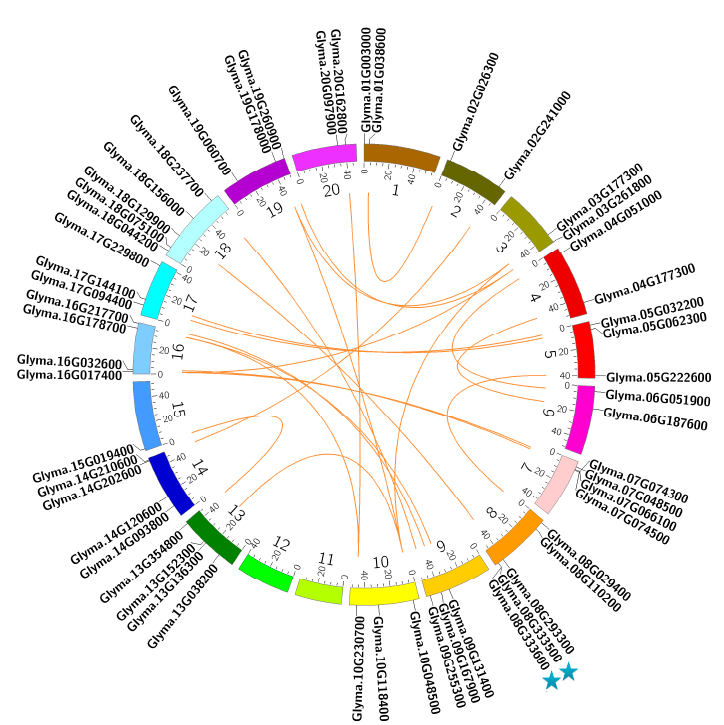
Figure 2. Chromosomal localization and duplication of CCA1-like genes in soybean. Each colored box refers to a chromosome, and chromosome numbers are shown beside each chromosome. The approximate localization of each soybean CCA1-like gene is indicated by a short black line. Tandem duplication is marked with star. The orange lines indicate the linkage group with segmentally duplicated gene pairs, and segmental duplication regions were estimated using the Plant Genome Duplication Database.